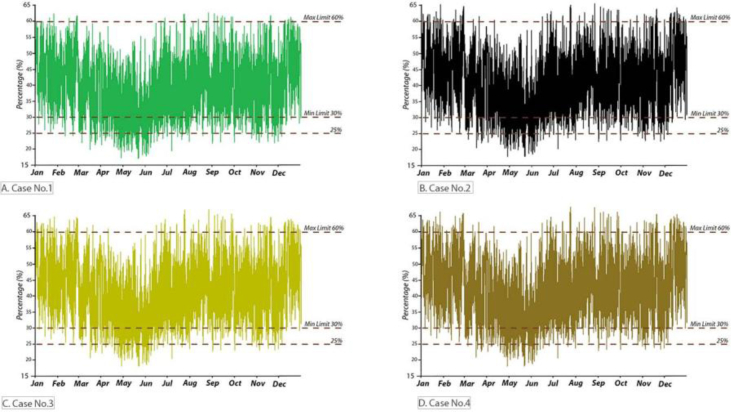
Annual RH inside the classroom for Case No.1, Case No.2, Case No.3, and Case No.4.